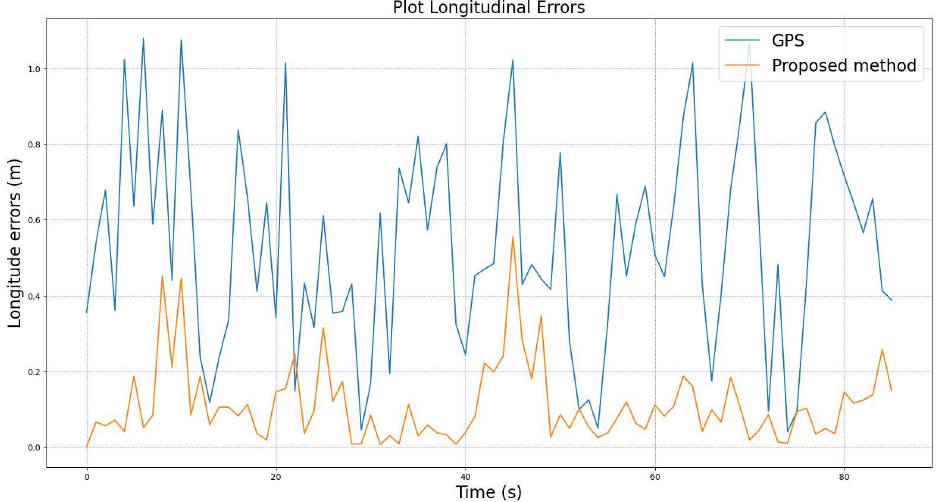
Figure 11. Comparison of longitudinal errors between the GPS and the proposed method.